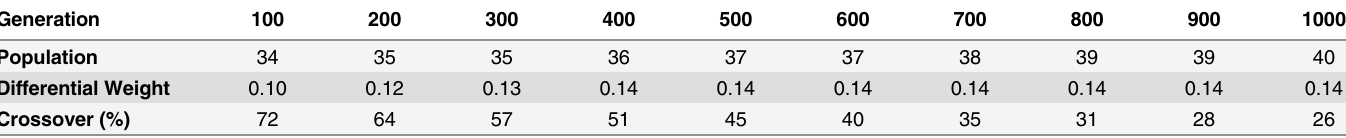
Table 1. Optimized setting of population size, differential weight & crossover at various maximum generation number.